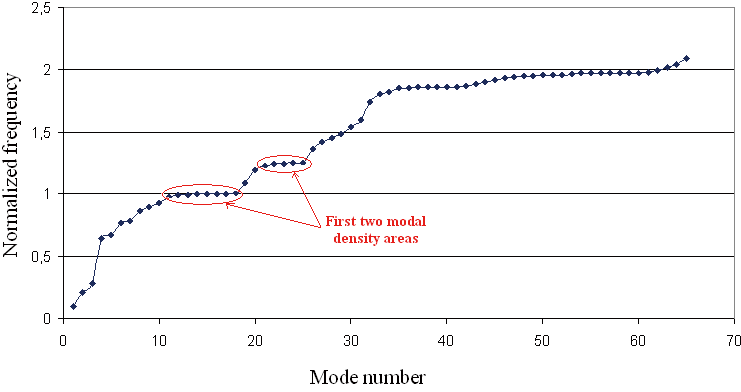
Fig. 2. Diagram representing the eigenfrequencies evolution functions of the eigenmode number (frequencies are normalized with respect to first stage’s mean